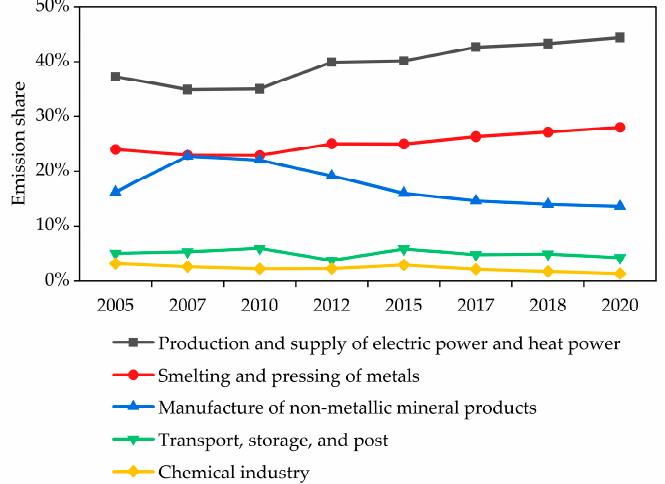
Figure 16. Emission share of main industries (2005–2020).